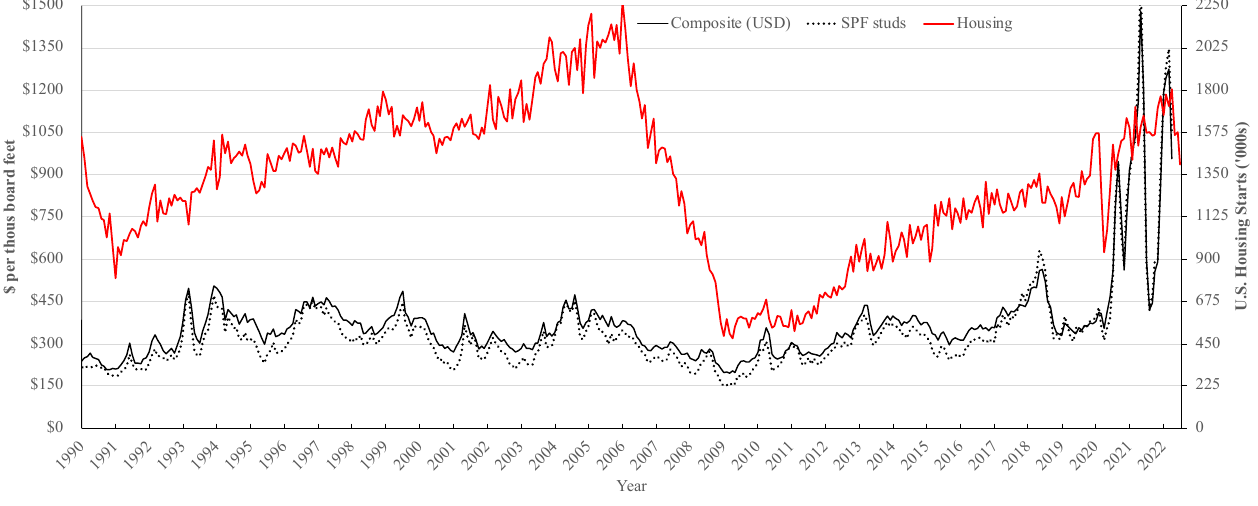
Figure 1. Monthly prices of lumber sold in the U.S. and the composite framing price index in USD, and U.S. housing starts, January 1990 through July 2022. Source: Authors’ calculations using data from [4–6].